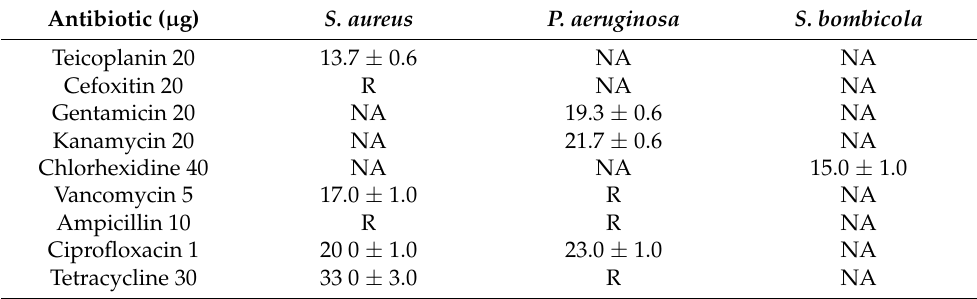
Table 3. The antibiotic resistance profiles of the test organisms S. aureus (MRSA 43300), P. aeruginosa (PA 01), and S. bombicola . Zones of inhibition less than 1 mm from antibiotic disc (Oxoid) were scored as resistant. Antibiotic doses in µ g. Resistant (R), not applicable